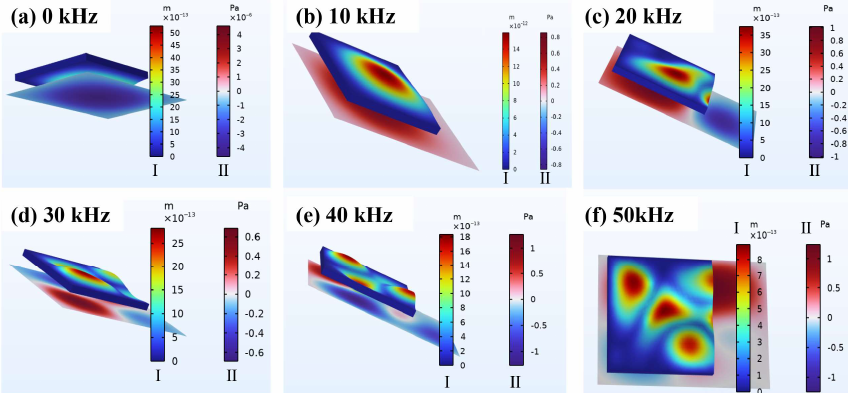
Figure 15. Increasing the density of displacements and acoustic compressive stresses as a function of increasing the frequency of ultrasonic irradiation ( a ) 0 kHz (without ultrasonics), ( b ) 10 kHz, ( c ) 20 kHz, ( d ) 30 kHz, ( e ) 40 kHz, and ( f ) 50 kHz. ( c ) 20 kHz, ( d ) 30 kHz, ( e ) 40 kHz, and ( f ) 50